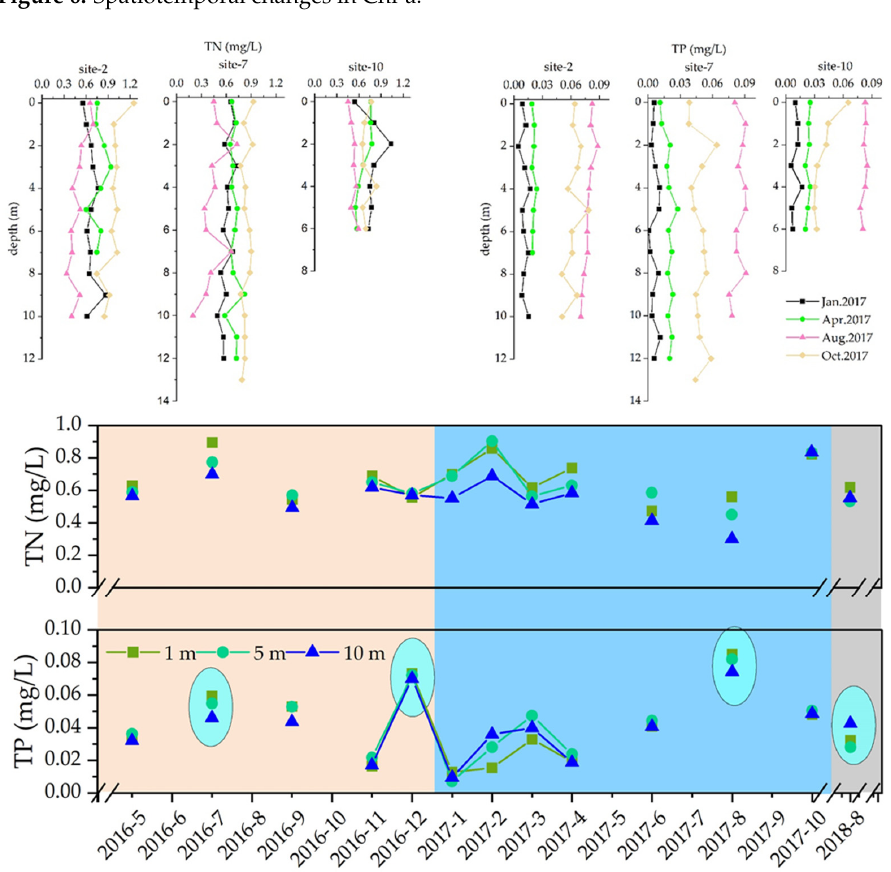
Figure 7. Spatiotemporal changes in TN and TP.